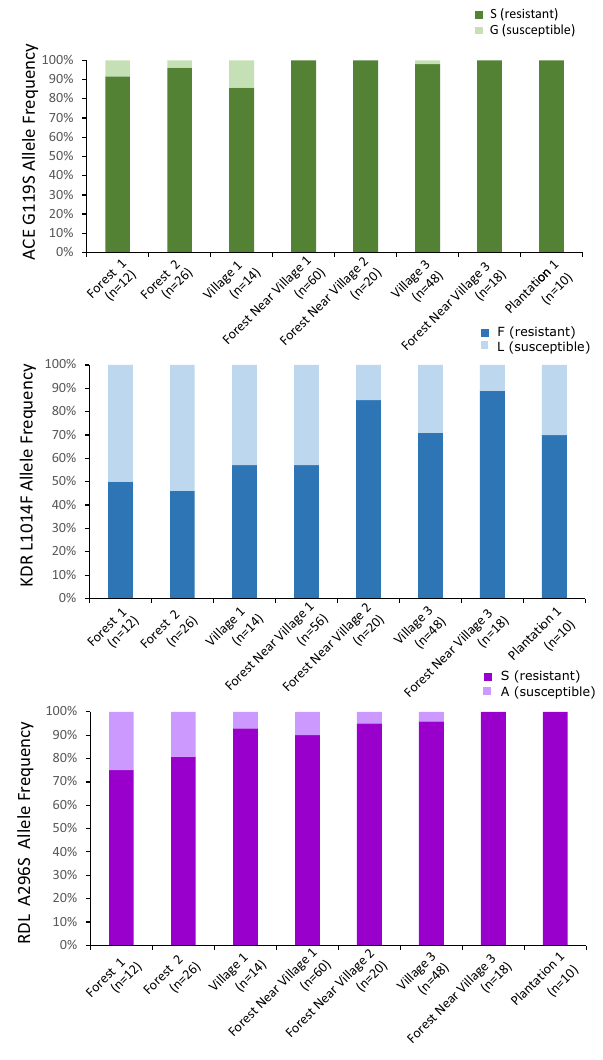
Figure 7. Geographic distribution of insecticide resistance mutations in A. peditaeniatus. Allele frequencies for ace-1 G1119S (top), kdr L1014F (middle) and rdl A196S (bottom) are shown as a function of sampling location. For kdr there is a detectable geographic pattern with the Forest site 2 exhibiting significantly ( p = 0.03) higher susceptible allele frequency than all other sites combined, while Forest near Village 2 ( p = 0.04) and 3 ( p = 0.02) exhibit significantly higher resistant allele frequencies than all other sites combined. A similar pattern is observed for rdl , but here the total number of susceptible alleles does not provide the power to detect significant differences. For locations: F = Forest, FNV = Forest Near Village, P = Plantation, and V = Village. Only those 8 sites with at least 5 A. peditaeniatus (10 alleles) are shown here. Resistant (res) and susceptible (sus) alleles are colored according to the legends, with resistant alleles in the darker